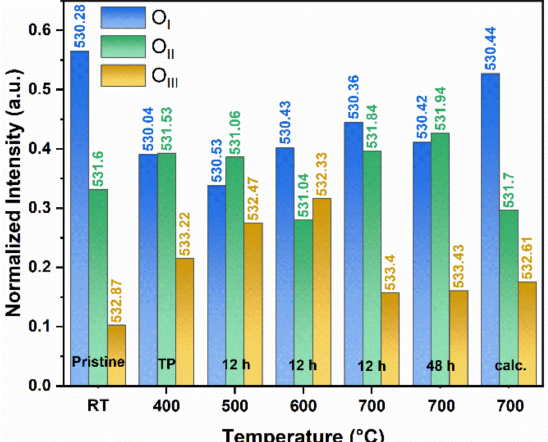
Figure 15. Relative intensities and binding energy values of XPS O 1s components of ZnO-(Q)NRs as-synthesized, after light-off curve investigation with temperature program (TP), after TOS reactions (500–700 ◦ C, 12 h), and after TOS reaction at 700 ◦ C, for 48 h and after calcination at 700 ◦ C (12 h) in